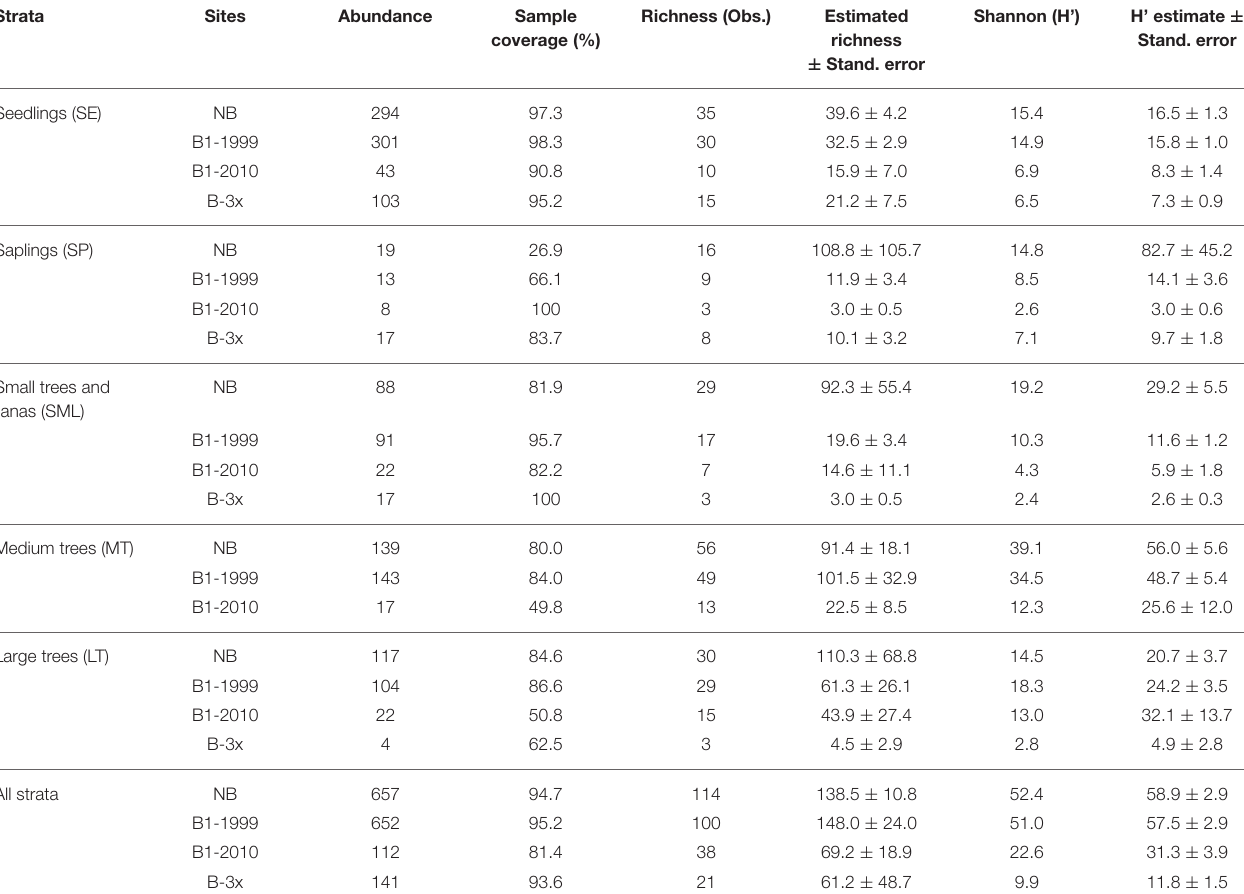
TABLE 2 | Descriptive data of species occurring in all four treatments and all five strata for the burned and unburned plots in southern Amazonia, Brazil. Strata Sites Abundance Sample